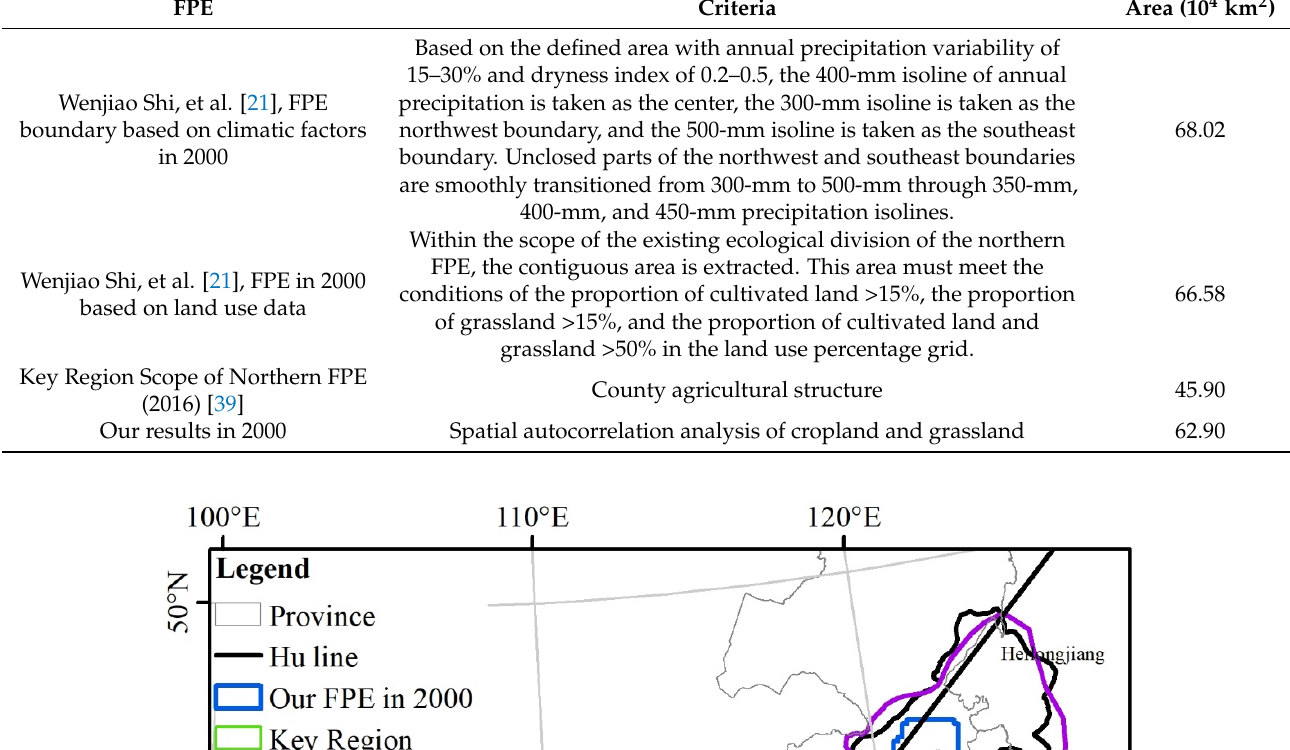
Table 3. Comparative Analysis of FPE with Different Criteria.